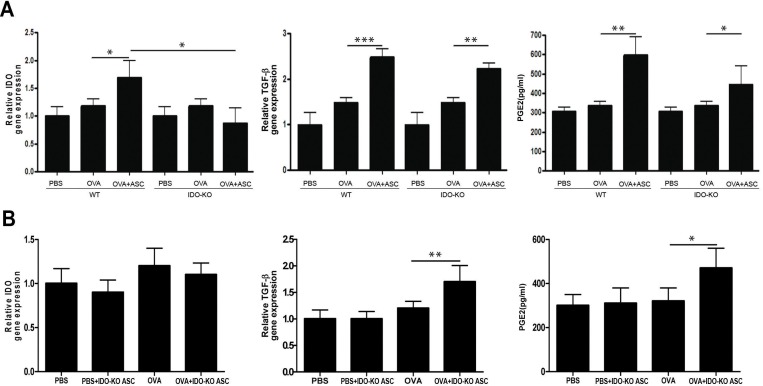
Effect of adipose-derived stem cells (ASCs) on the expression of IDO, TGF-β, and PGE2.ASCs (A) or ASCs derived from indoleamine 2, 3-dioxygenase (IDO)-knockout (KO) mice (B) treatment significantly increased TGF-β expression in lung tissue and PGE2 levels in the serum of asthmatic mice. However, IDO expression in lung tissue was increased in the OVA+ASC group of WT asthmatic mice, but not in the OVA+ASC group of IDO-KO asthmatic mice and OVA+IDO-KO ASC group. Data are expressed as the mean ± SEM of four independent experiments performed in triplicate. *
p<0.05, **
p≤0.005, ***
p≤0.001.